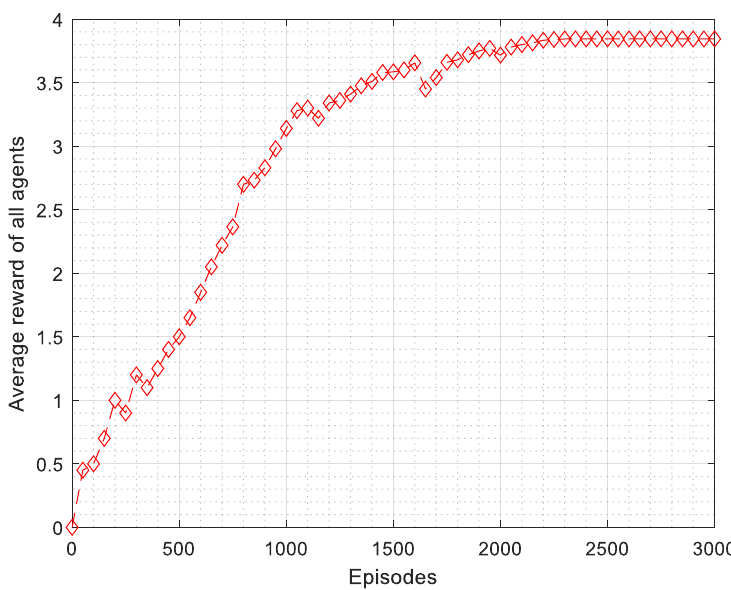
Figure 14. Improvement of 𝑃𝑑 during TA-RL-based CSS.